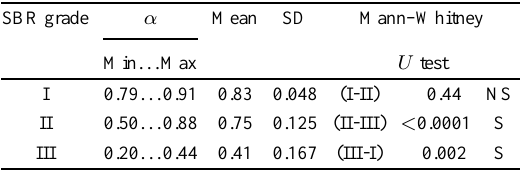
Statistical analysis for slope (cid:11) between grade I, II, and III; Mann– Whitney U test (significant if p < 0 :